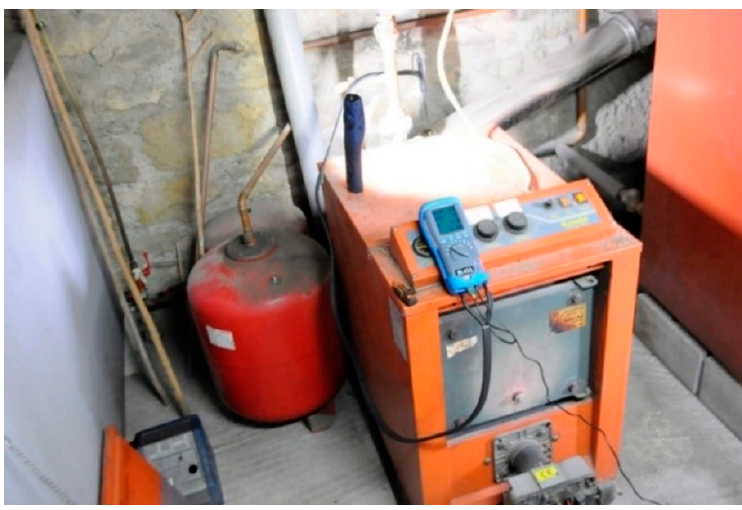
Figure 2. Exhaust gas measurement during the Mountainous Living Lab [49].